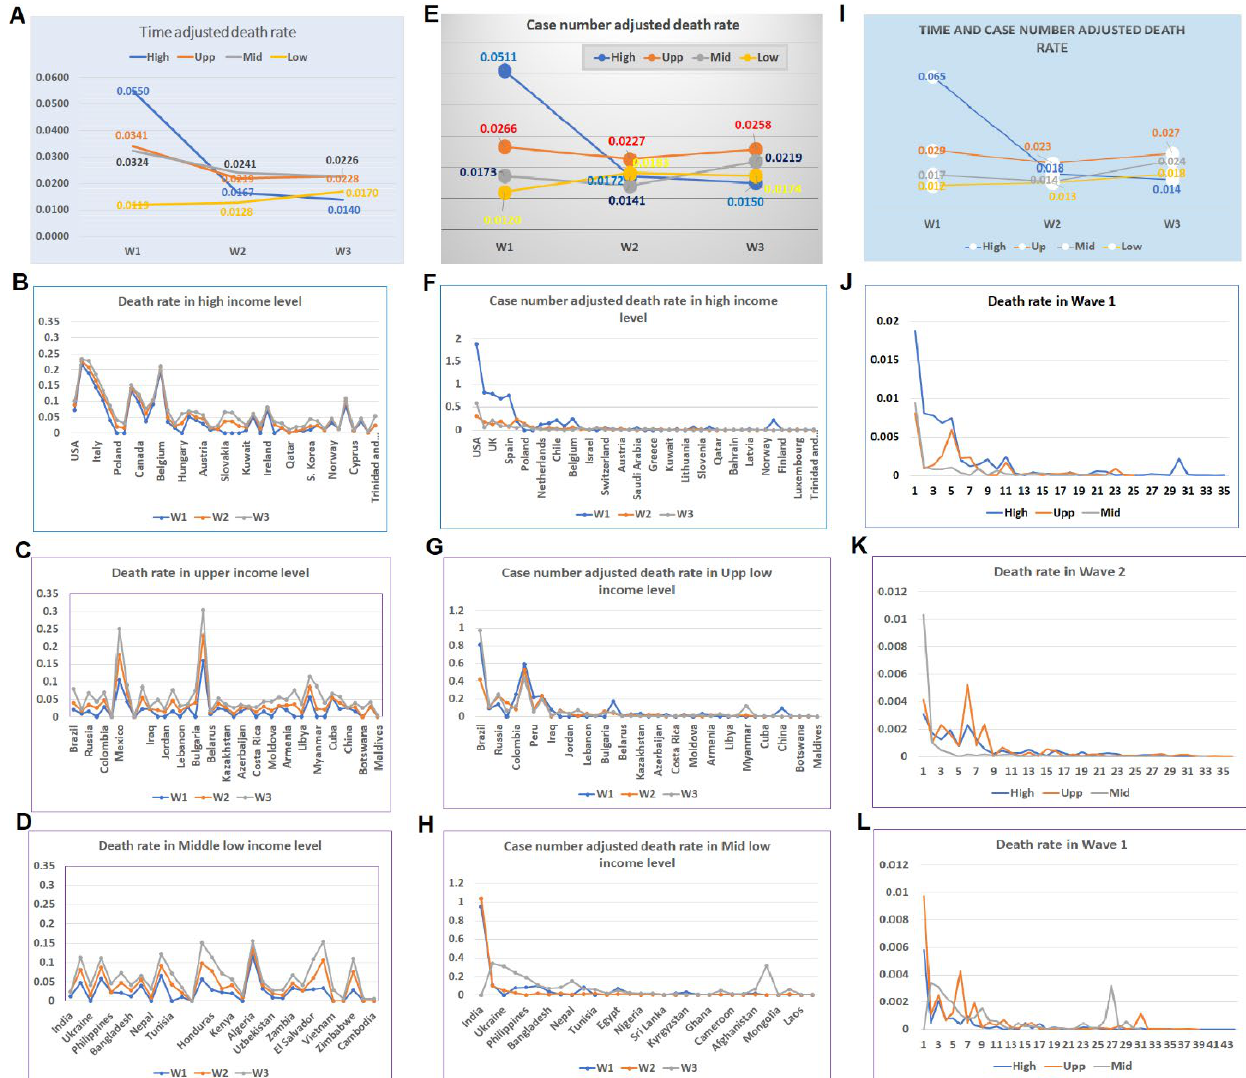
Figure 5. Mortalities based on timeline and case-number-adjusted data. ( A – D ) Mortalities based on timeline-adjusted data. ( A ) The average number of deaths in CRs at different income levels in three waves of disease based on the timeline. ( B ) Distributions of mortalities in high-income level CRs by timeline. ( C ) Distributions of mortalities in upper-middle-income level CRs by timeline. ( D ) Distributions of mortalities in lower-middle-income level CRs by timeline. ( E – H ) Mortalities based on case-number-adjusted data. ( E ) The average number of deaths in CRs at different income levels in three waves of disease by cases. ( F ) Distributions of mortalities in high-income level CRs by cases. ( G ) Distributions of mortalities in upper-middle-income level CRs by cases. (H ) Distributions of mortalities in lower-middle-income level CRs by cases. ( I – L ) Mortalities based on timeline- and case-number-adjusted data. ( I ) The average number of deaths in CRs at a different income level in three waves of disease by timeline and cases. ( J ) Distributions of mortalities in high-income level CRs by timeline and cases. ( K ) Distributions of mortalities in upper-middle-income level CRs by timeline and cases. ( L ) Distributions of mortalities in lower-middle-income level CRs by timeline and cases.